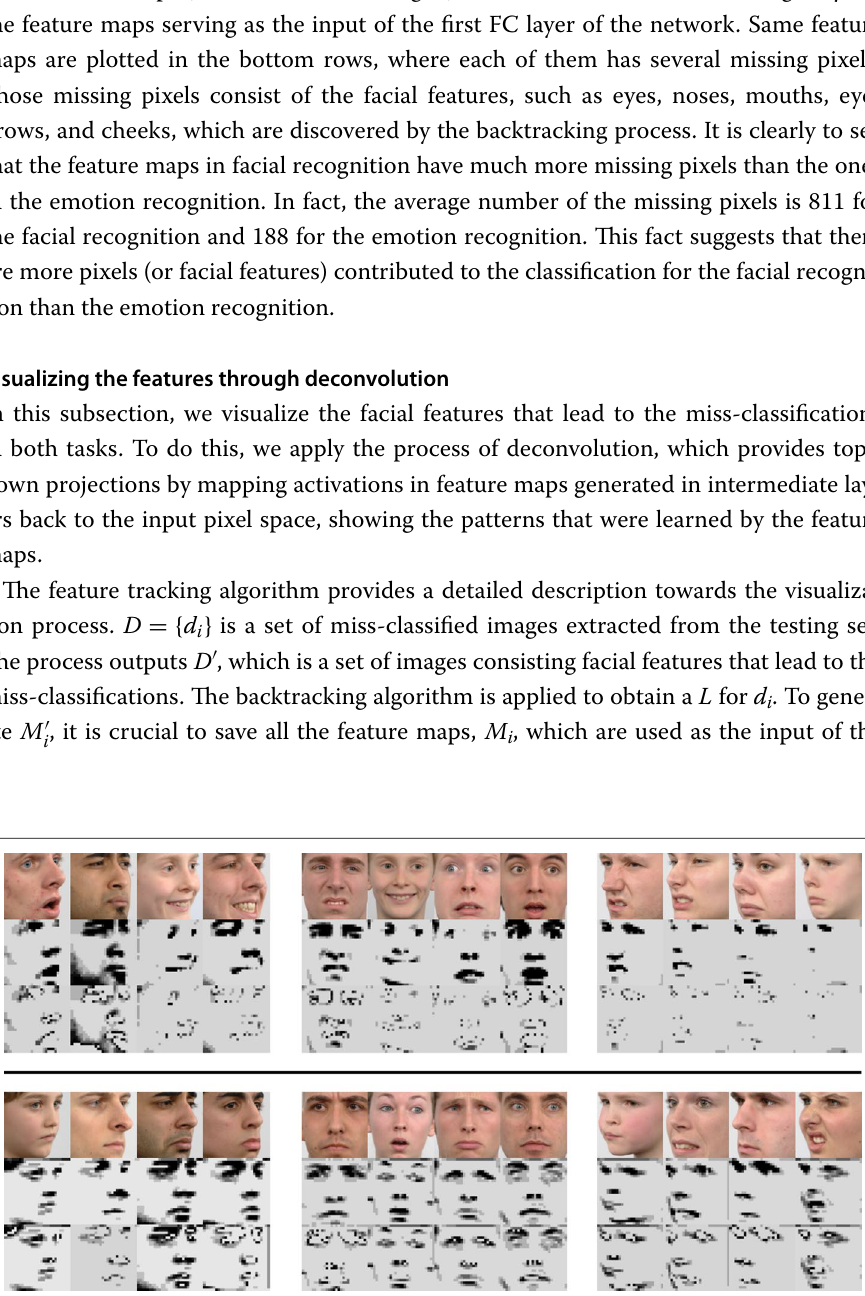
Fig. 7 Above the line: feature maps in facial recognition. Below the line: feature maps in emotion recogni- tion. Top row: original images. Middle row: feature maps. Bottom row: feature maps with missing